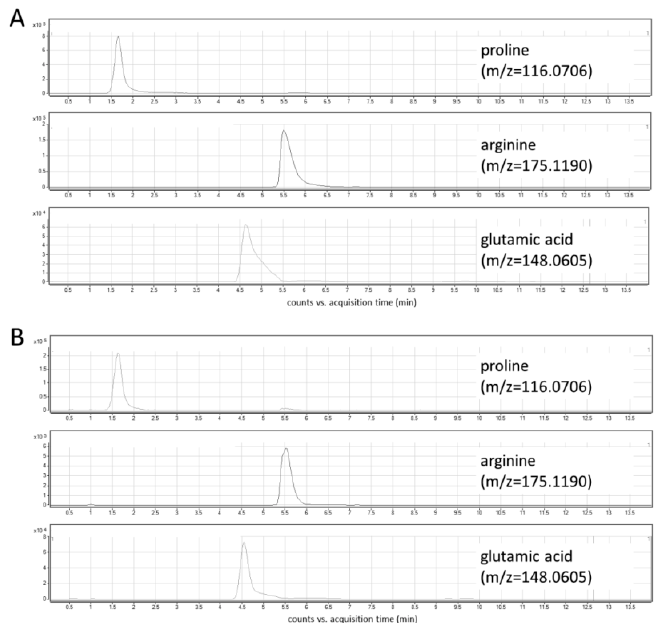
Figure 3. Extracted ion chromatograms of target metabolites: ( A ) standard solution; ( B ) cell lysate.